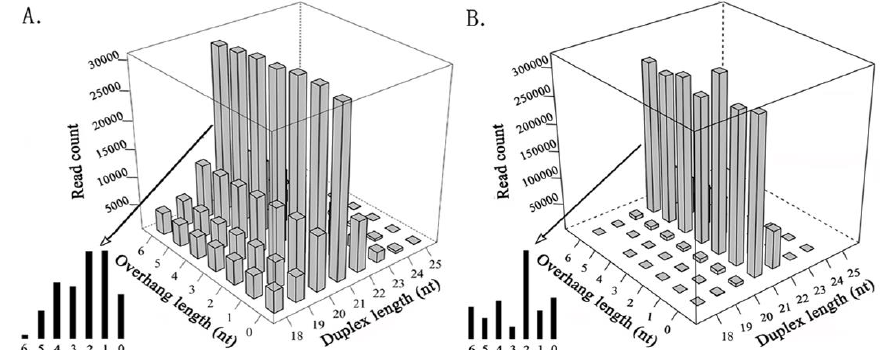
Figure 1. Comparison of small interfering RNA (siRNA) duplexes that were induced by plant and invertebrate viruses. All of the cleaned small RNA sequencing (sRNA-seq) reads were aligned to viral genome sequences using the software Bowtie v0.12.7 [13] with one mismatch. The detection of siRNA duplexes was performed using the program duplexfinder [7]. ( A ). The read count of siRNA duplexes varies with the duplex length and the overhang length, using data from 11 invertebrate viral genomes. ( B ). The read count of siRNA duplexes varies with the duplex length and the overhang length, using data from seven plant viral genomes [7].